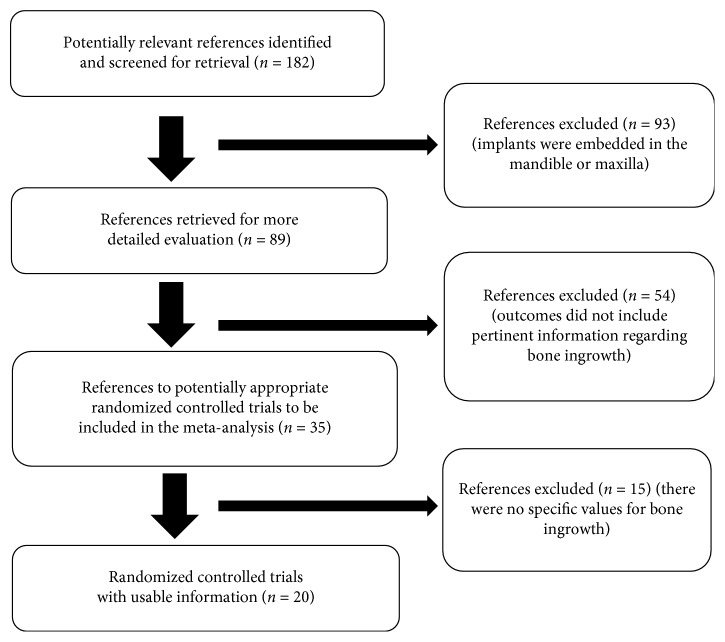
Flow of studies through the review.